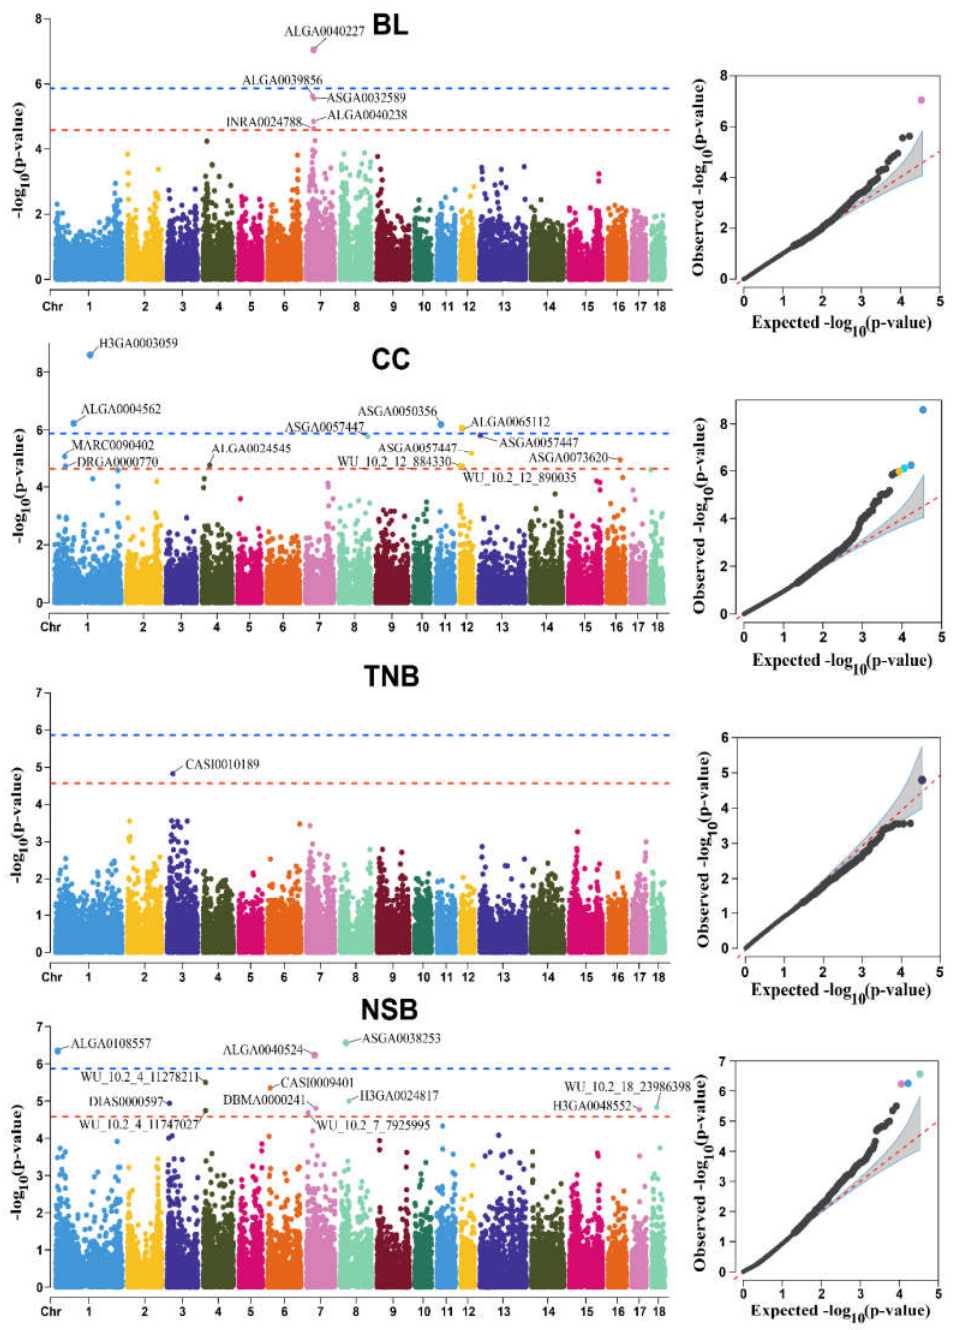
Figure 3. Manhattan and quantile-quantile (QQ) plots of the observed -log 10 ( p -values) for BL, CC, TNB, and NSB in Shaziling pigs. The horizontal red and blue dashed lines in the Manhattan plots indicate the suggestive level (2.38 × 10 -5 ) and significant level (1.19 × 10 -6 ), respectively. The QQ plots show the observed -log 10 -transformed P -values (y-axis) and the expected -log 10 -transformed p -values (x-axis). Table 2. Potential single-nucleotide polymorphisms (SNPs) and candidate genes identified by the genome-wide association study for body size and reproduction traits.